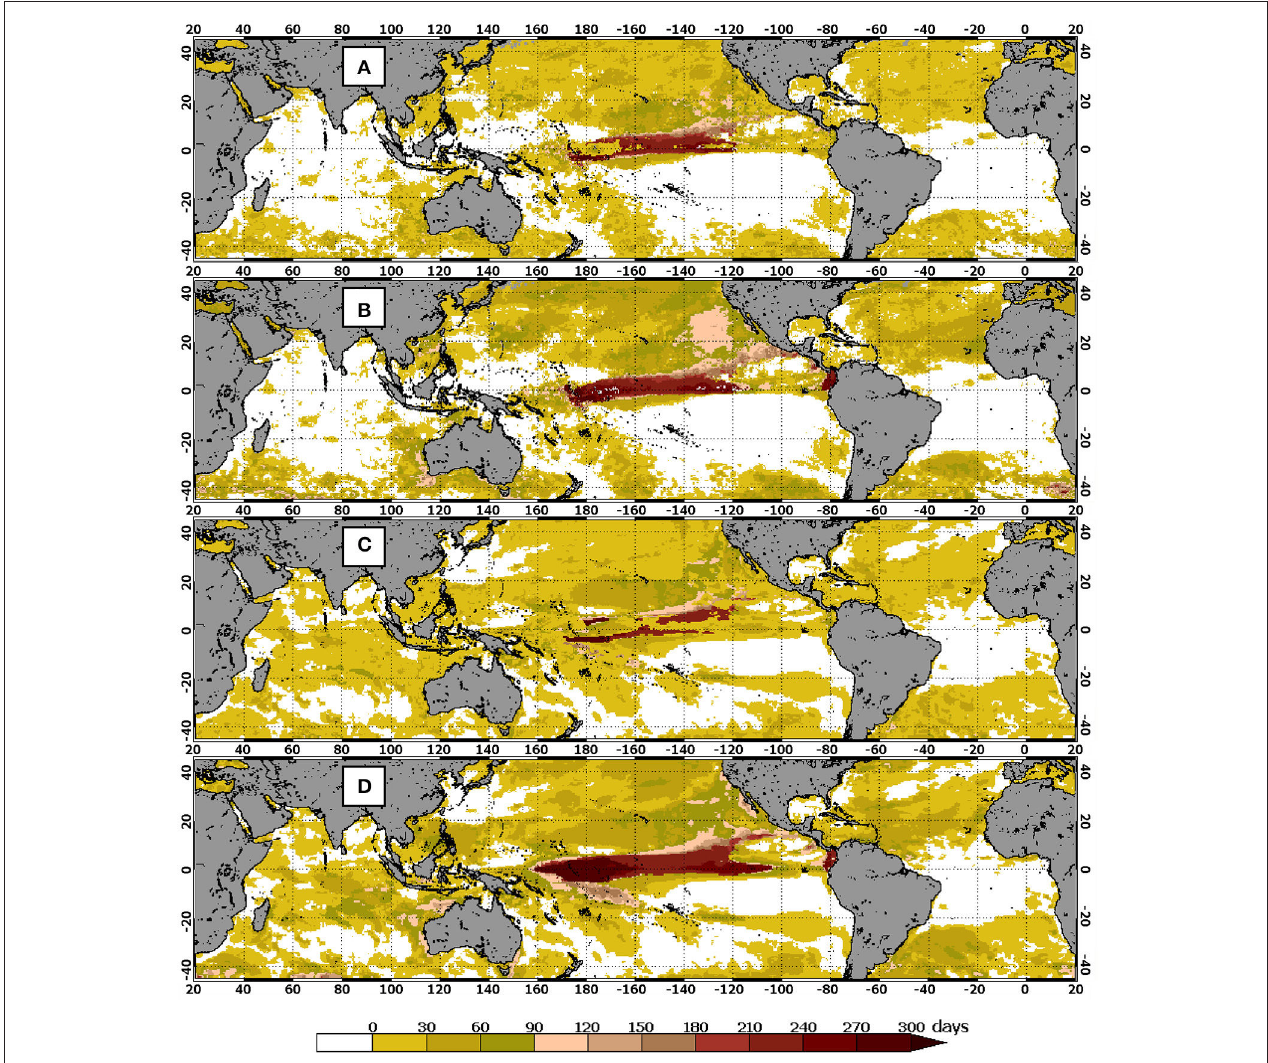
FIGURE 9 | The shortest (A) and longest (B) event durations identified by CRW’s 50km satellite monitoring and the shortest (C) and longest (D) event durations predicted by CRW’s weekly Outlooks (Version 3) of 60% probability with a lead-time of 5-weeks during August 1, 2011–December 27, 2015.